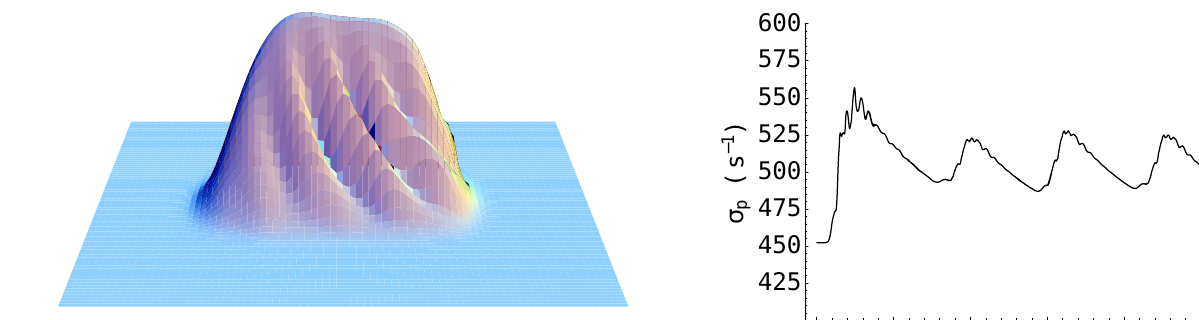
FIG. 6. (Color) Plot of a simulated 350 mA microwave-unstable fully stretched bunch in the NSLS VUV ring. The impedance is that of a Q (cid:1) 1.118 resonator with j Z n (cid:3) n j (cid:1) 1.84 V and resonant frequency 2.0 GHz. Phase increases from left to right with the leading edge of the bunch to the right. Energy increases from front to back. Machine parameters are given in Table I.